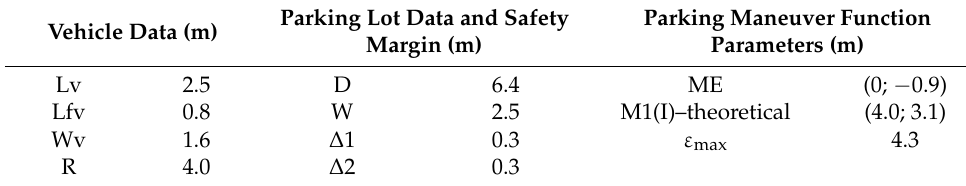
Table 2. Vehicle and parking lot data, and parking maneuver function parameters for the maneuver type choice.